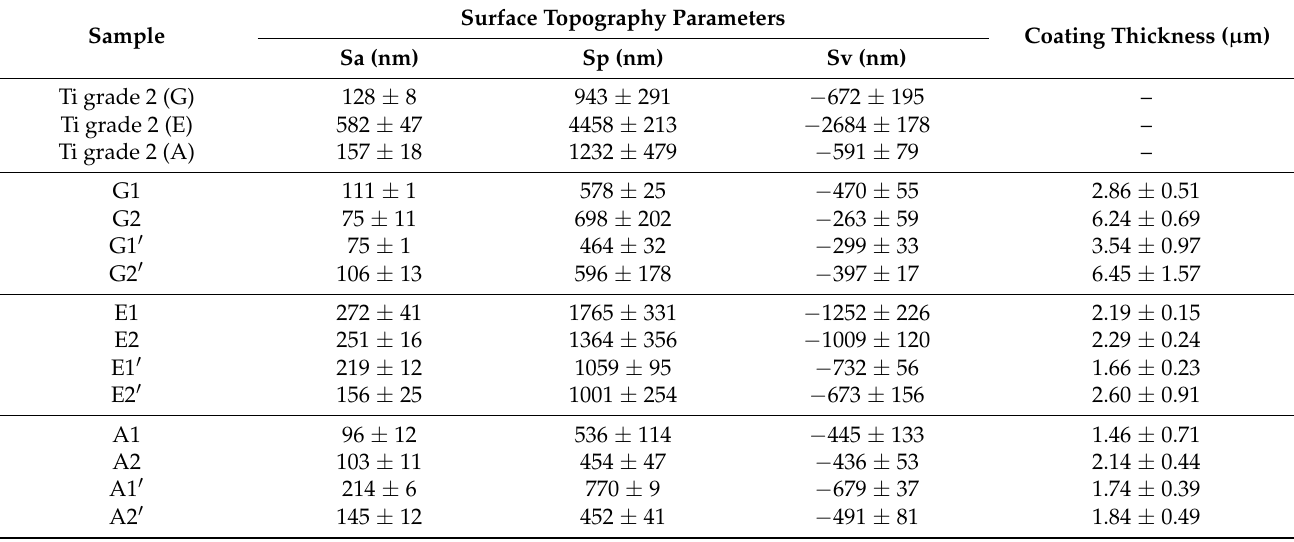
Table 3. Surface topography parameters and coatings’ thickness measurement